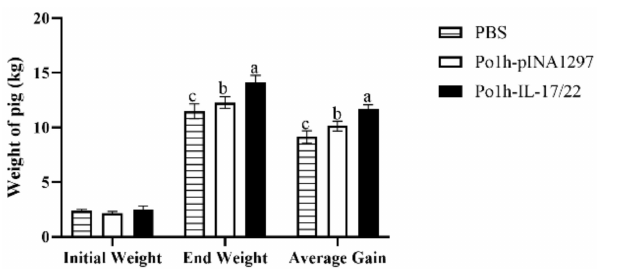
Figure 10. Changes in piglet weights during 8 weeks of observation (n = 10/group). The data with different lowercase letter are significantly different, p < 0.05.